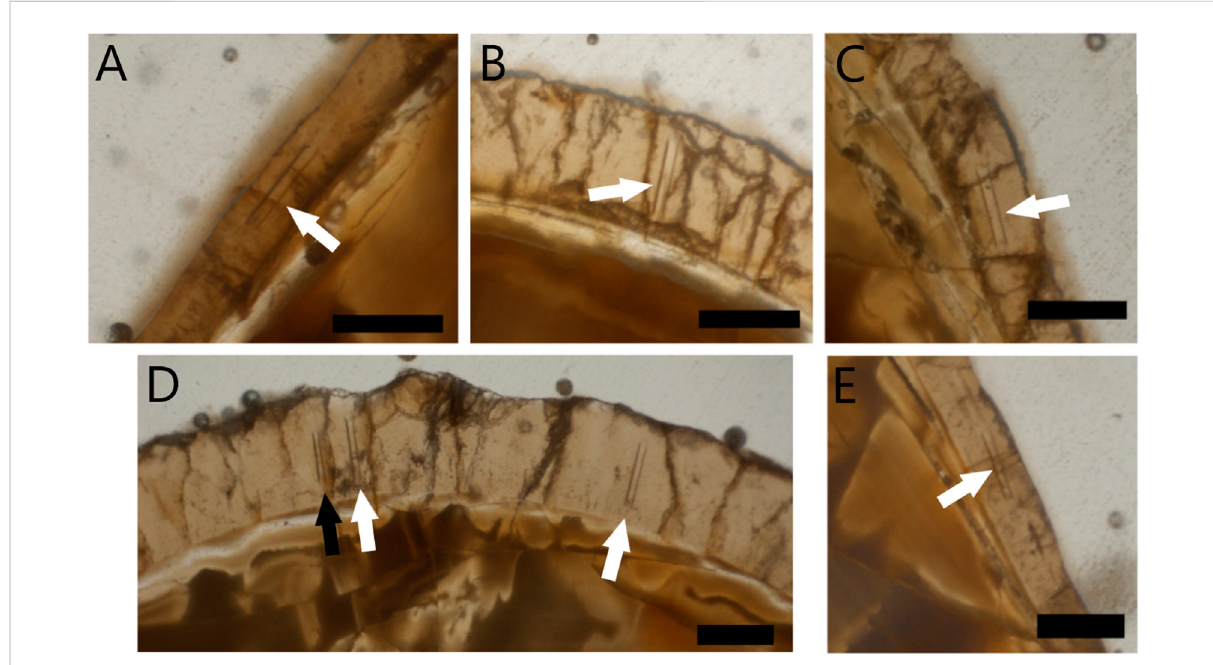
FIGURE 1 Laser ablated areas of enamel of two thin sections of isolated tooth 1 (IT-1) from cf. Prognathodon (CGP/1/2265). Two single thin sections represented (A – C) and (D , E) .Whitearrowsindicateregionswhereenamelwasablatedforanalysisandblackarrowindicatesinitialtrialablation.Scale bars = 100 μ